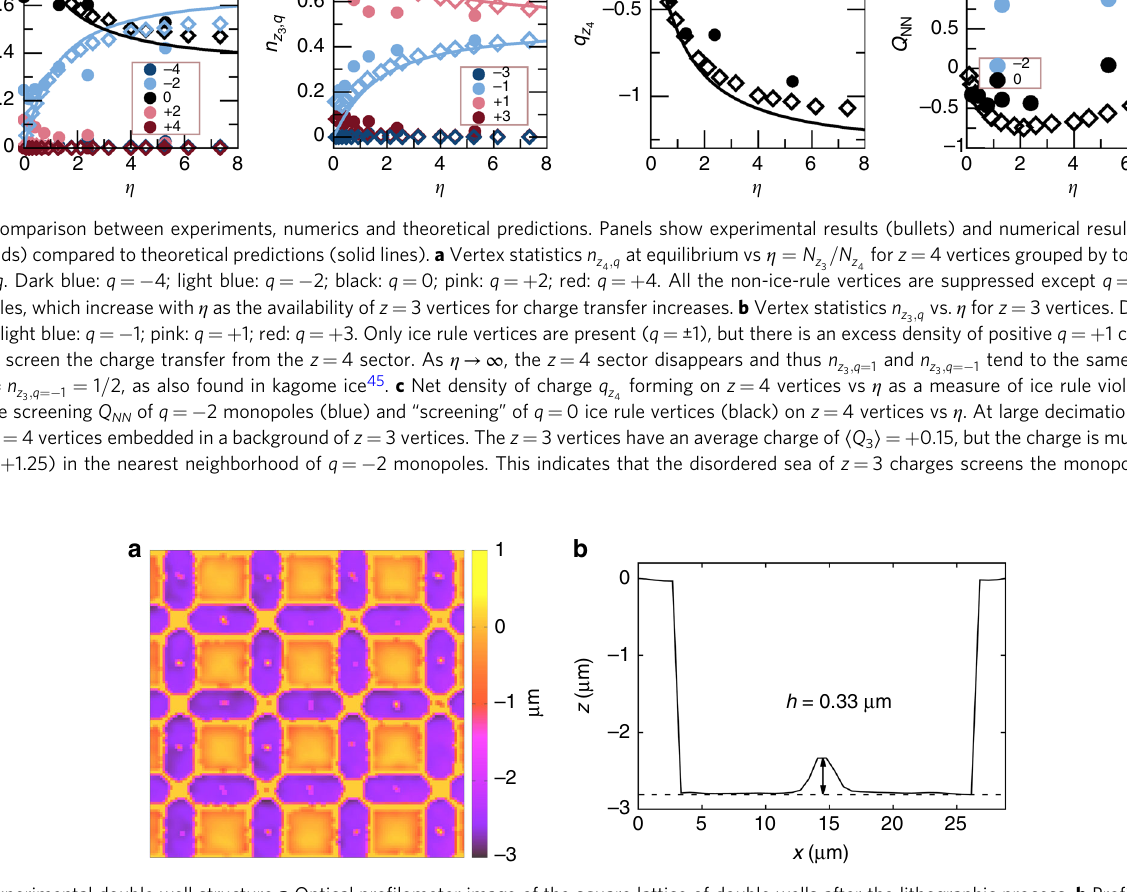
Fig. 6 Experimental double well structure a Optical pro fi lometer image of the square lattice of double wells after the lithographic process. b Pro fi le of one double well characterized by a central hill of elevation h = 0.33 μ